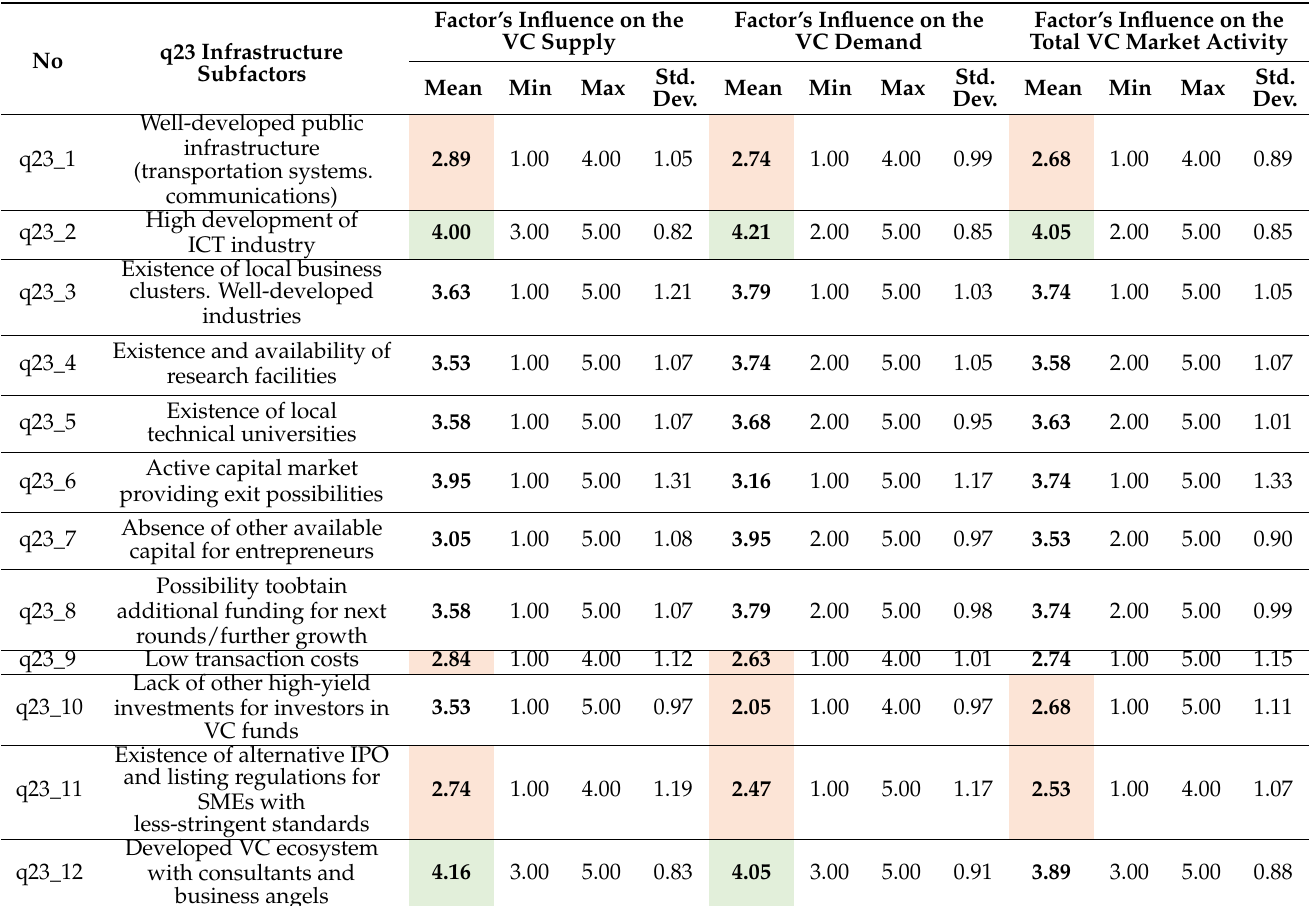
Table 13. The subfactors related to